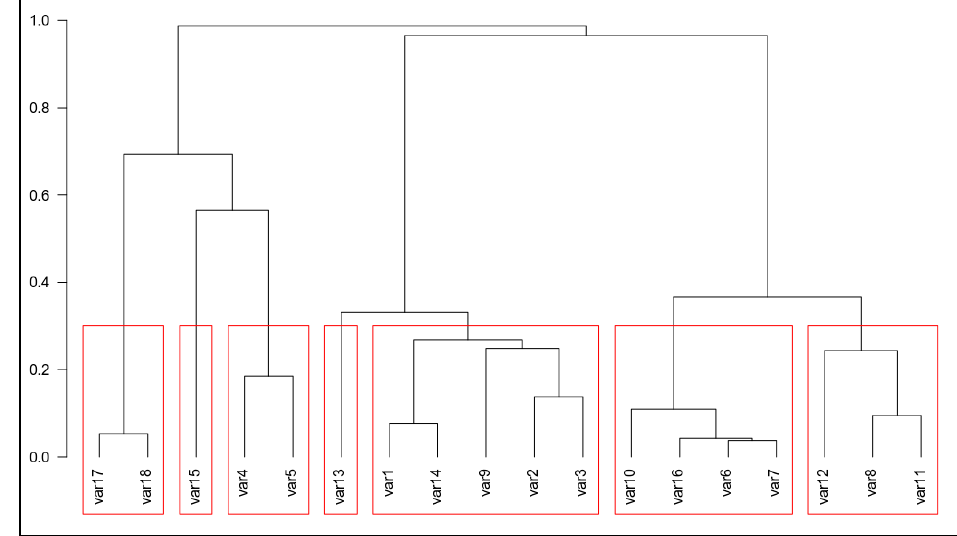
Figure 4. Groups of intercorrelated variables from the ENVIREM dataset to cutoff 0.7; y -axis as in Figure 2. Variables (var): var2—Thornthwaite aridity index (I Th ), var4—continentality, var6—growing degree days with mean temperature greater than 0 °C (gdd0), var8—maximum temperature of the coldest month, var13—monthly variability in potential evapotranspiration (PET), var15—mean monthly PET of the warmest quarter, var18—topographic wetness index. Discarded variables: